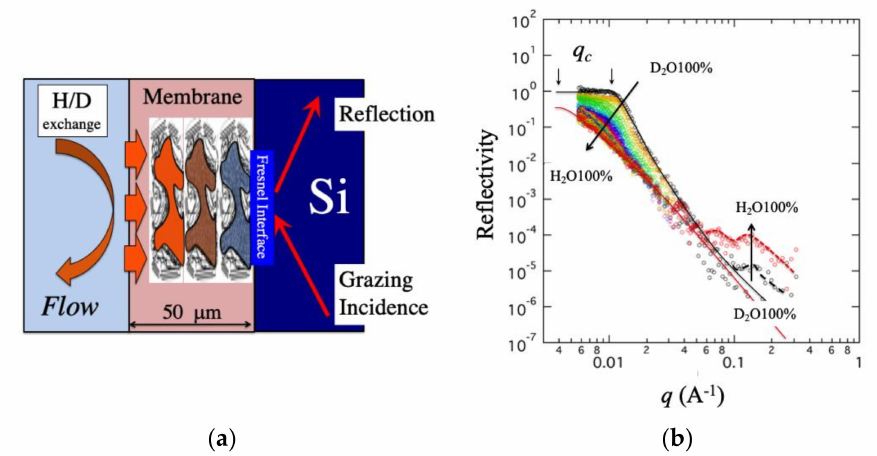
Figure 16. Schematic diagram showing ( a ) the Fresnel surface between Nafion ® film and the silicon substrate, and ( b ) time-resolved total reflection during water exchange from D 2 O to H 2 O, in order to examine water di ff usion across the bulk film. Di ff erent colors indicate the reflectivity (RF) profiles obtained at di ff erent times between 0 and 3 h with a time interval 5